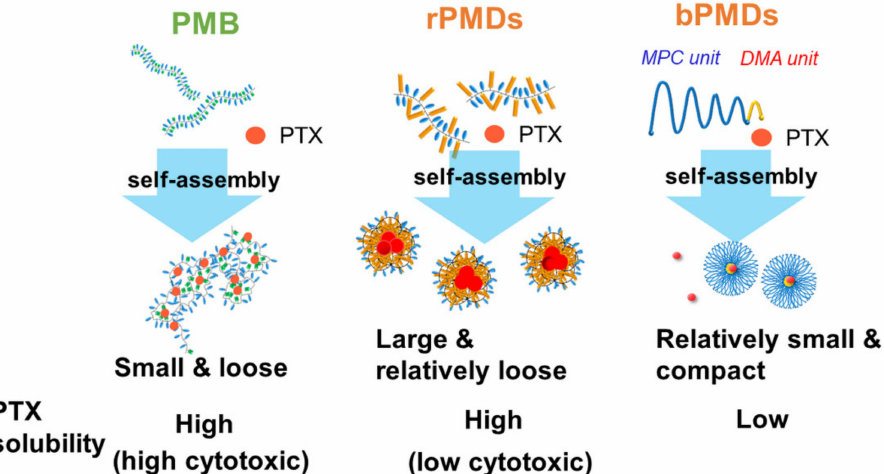
Figure 7. Schematic of the self-assembly and PTX solubility of various amphiphilic MPC